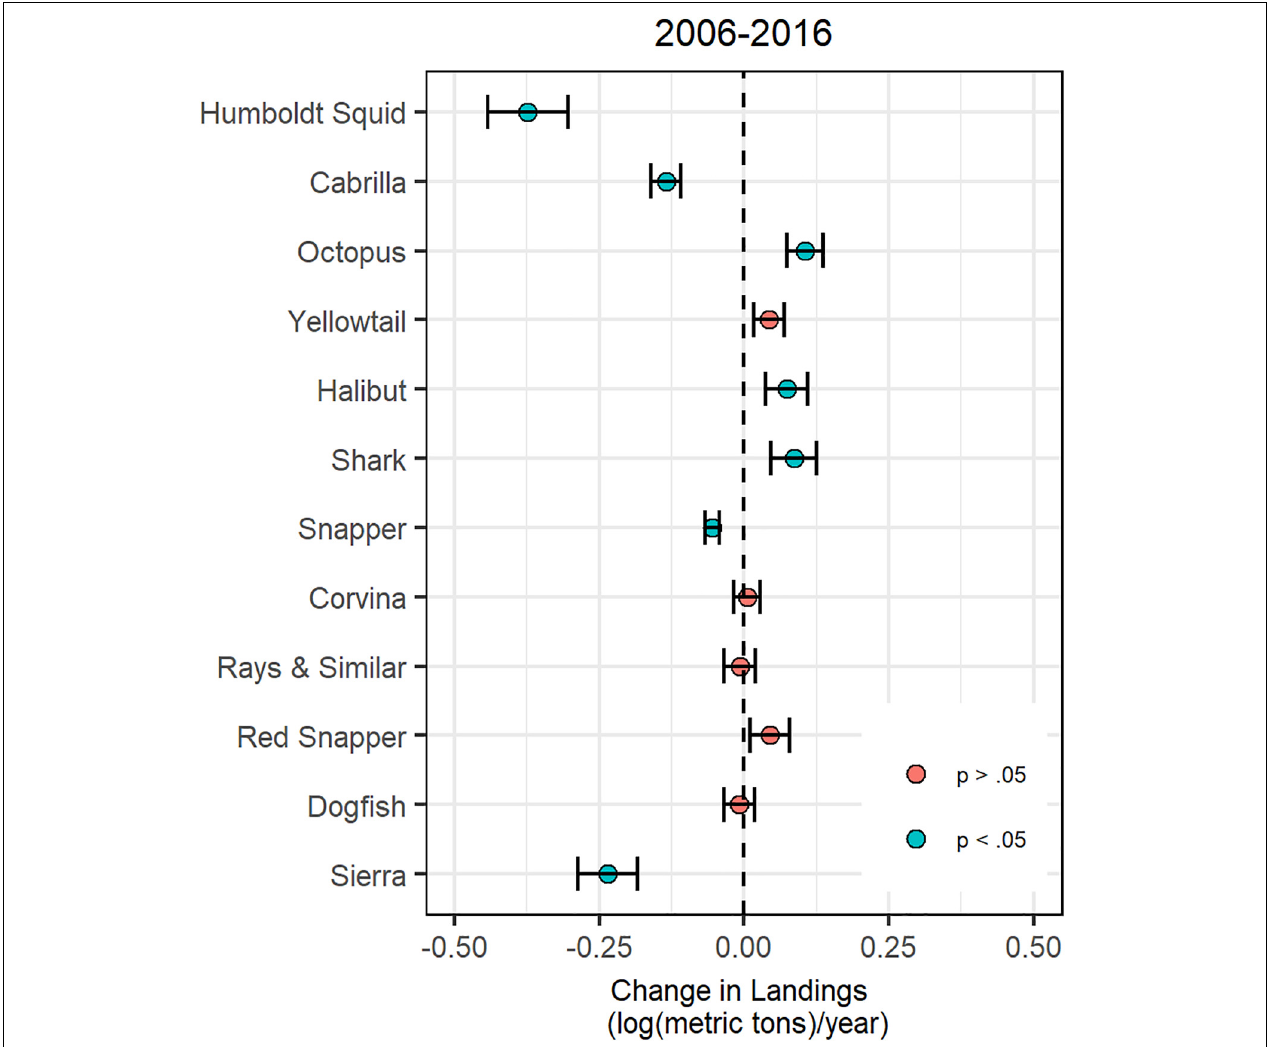
FIGURE 2 | Fisheries landings trends characterizing small-scale fishing activity between 2006 and 2016 in coastal waters offshore Santa Rosalía and adjacent communities, as inferred by monthly landings data. Species/family groupings are displayed in order of their relative contribution to total fisheries value over the same time